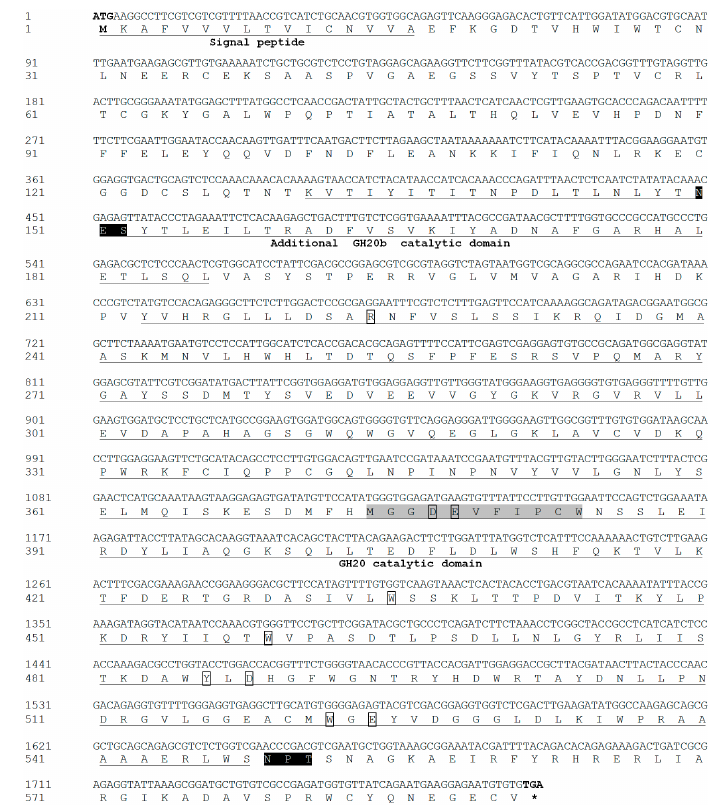
Figure 1. Nucleotide and deduced amino acid sequences of LsNAG2 complementary DNA. The start codon is indicated in bold and the stop codon in bold with an asterisk. The predicted signal peptide, glycoside hydrolase family 20 (GH20) catalytic domain, and an additional GH20b domain are underlined. The conserved catalytic sites are shaded. The potential glycosylation sites are in white with a blank background, and the catalytically active sites are boxed.